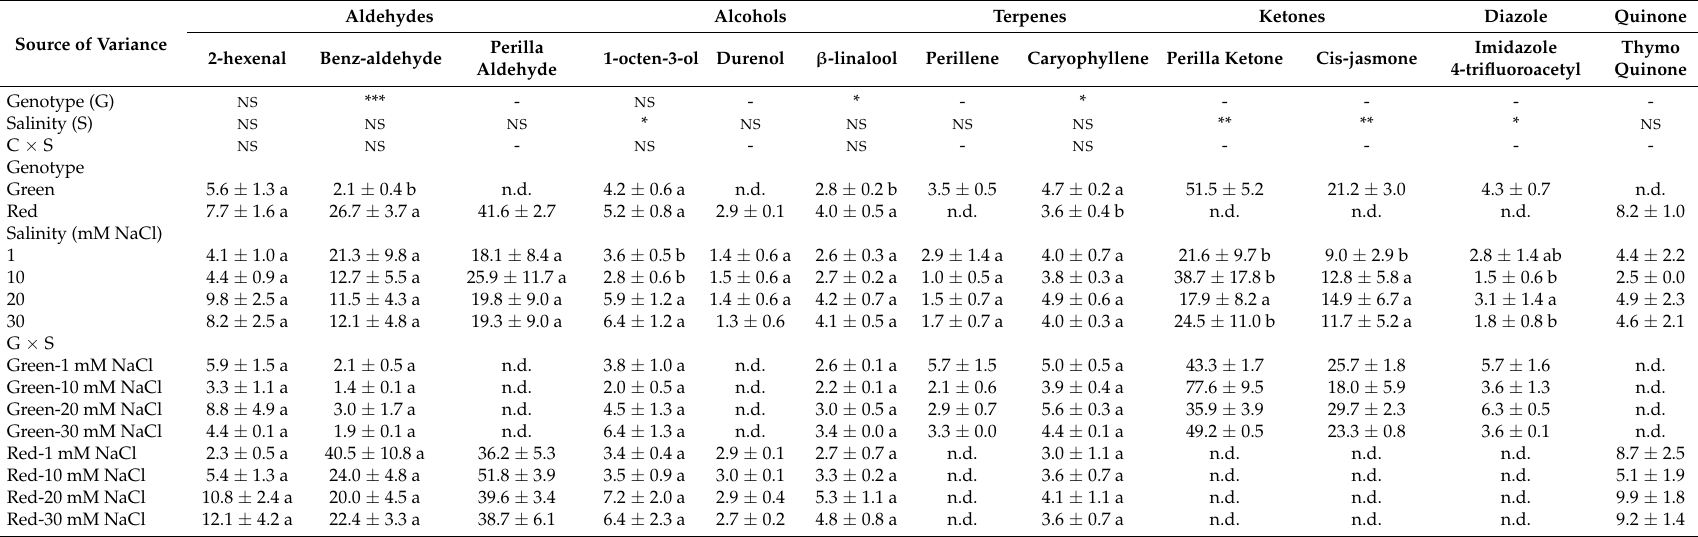
Table 4. Analysis of variance and mean comparisons for the relative abundance of major aroma volatile components in green and red perilla grown under increasing NaCl concentration in the nutrient